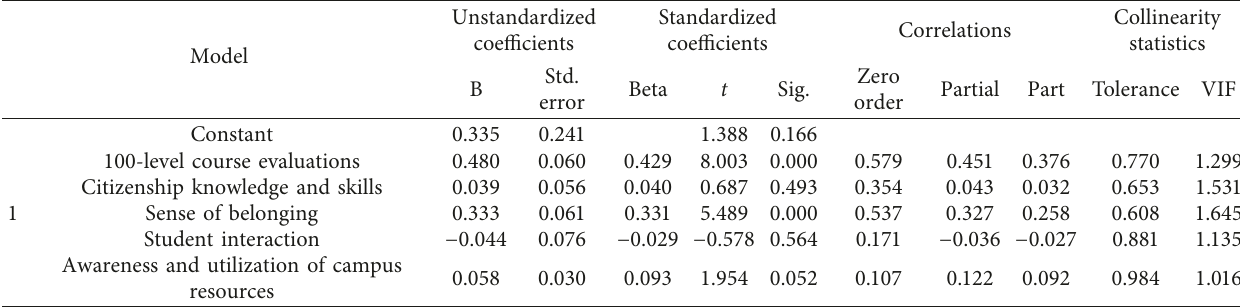
Table 7: Coefficient of determination.